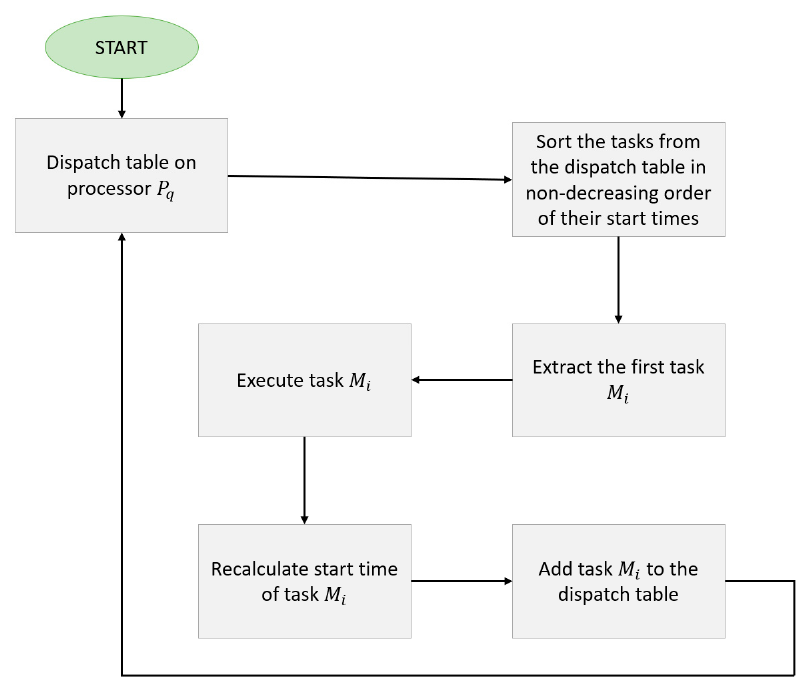
Figure 7. Online phase execution.